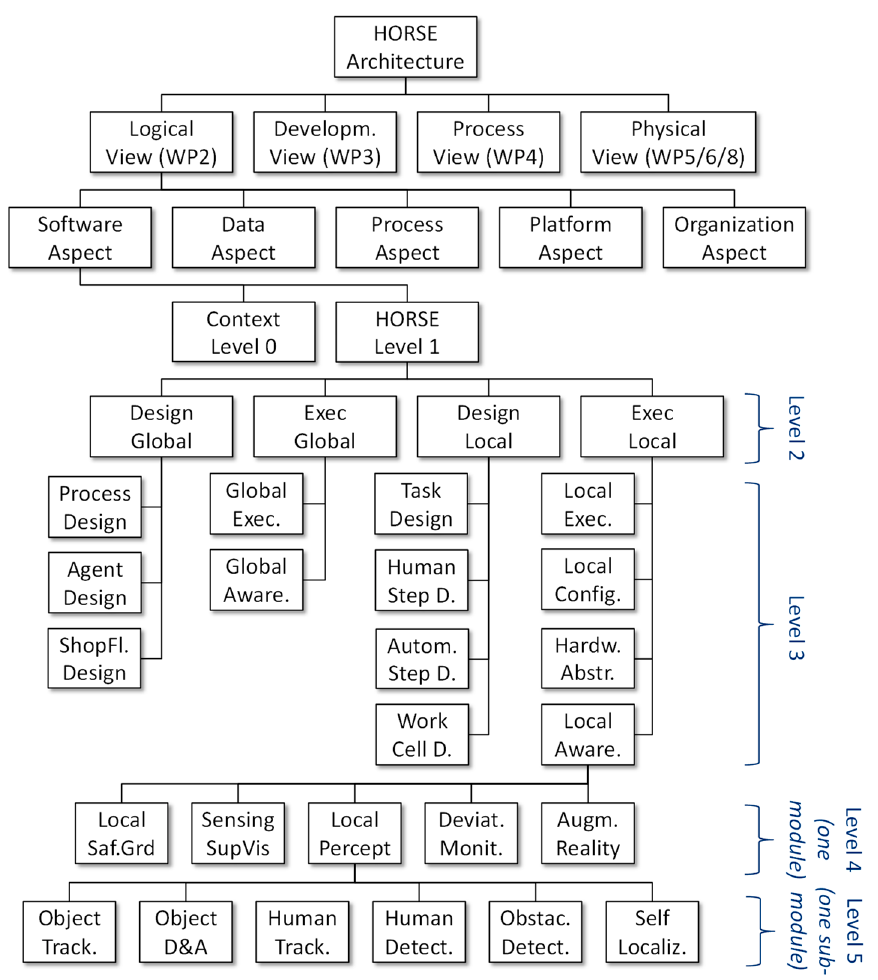
Figure 8. Part of the HORSE architecture structure [27].